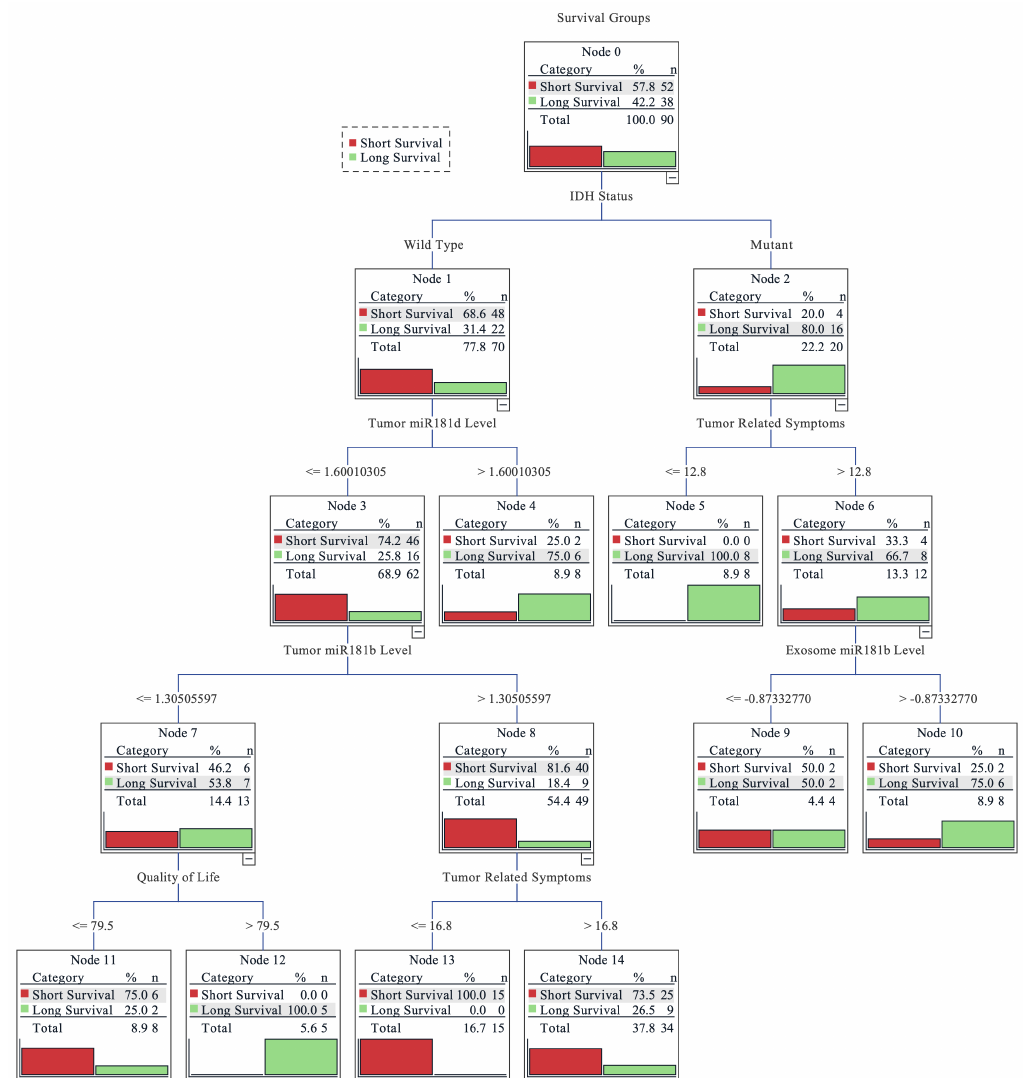
Figure 5. Decision tree for predicting grade II-IV glioma patients’ survival. Grouped into two subgroups according to the cohort survival mean: < 16.85 months—short survival; ≥ 16.85 months—long survival. The earlier factor appearance (vertically going from top to bottom) shows its higher importance to the prediction model. Values on the lines indicate the factor value at which the algorithm divided the factor groups. For miR-181 expression levels, the fold change value was used; the higher tumor related symbol score reflects more pronounced symptoms and the higher quality of life score indicates better functional and psychological well-being of the